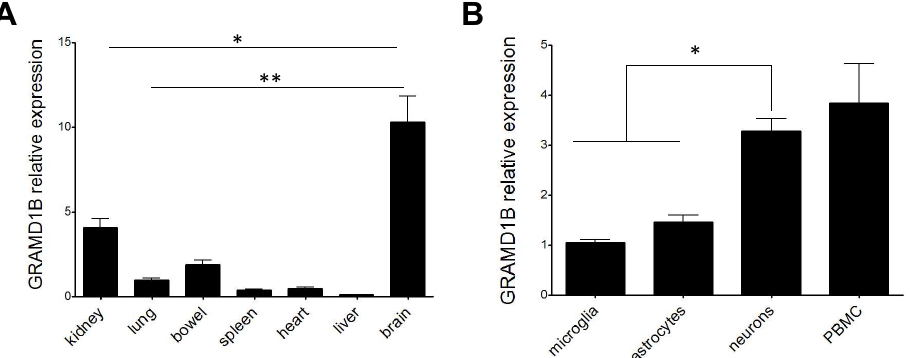
Figure 5. GRAMD1B expression profile across different rat tissues and cell types. Relative expression of GRAMD1B gene in rat tissues from n = 3 rats ( A ) and rat cell types ( B ). Error bars represent SEM. p -values refer to the comparison of expression values between brain and other types of tissues ( A ) or between neurons and other cell types ( B ). * p < 0.05, ** p < 0.01.